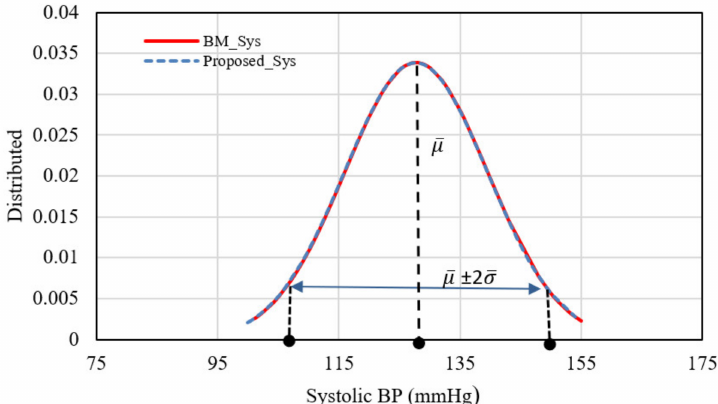
Figure 11. The PDF test of the systolic BP measurements against their corresponding benchmark measurements.